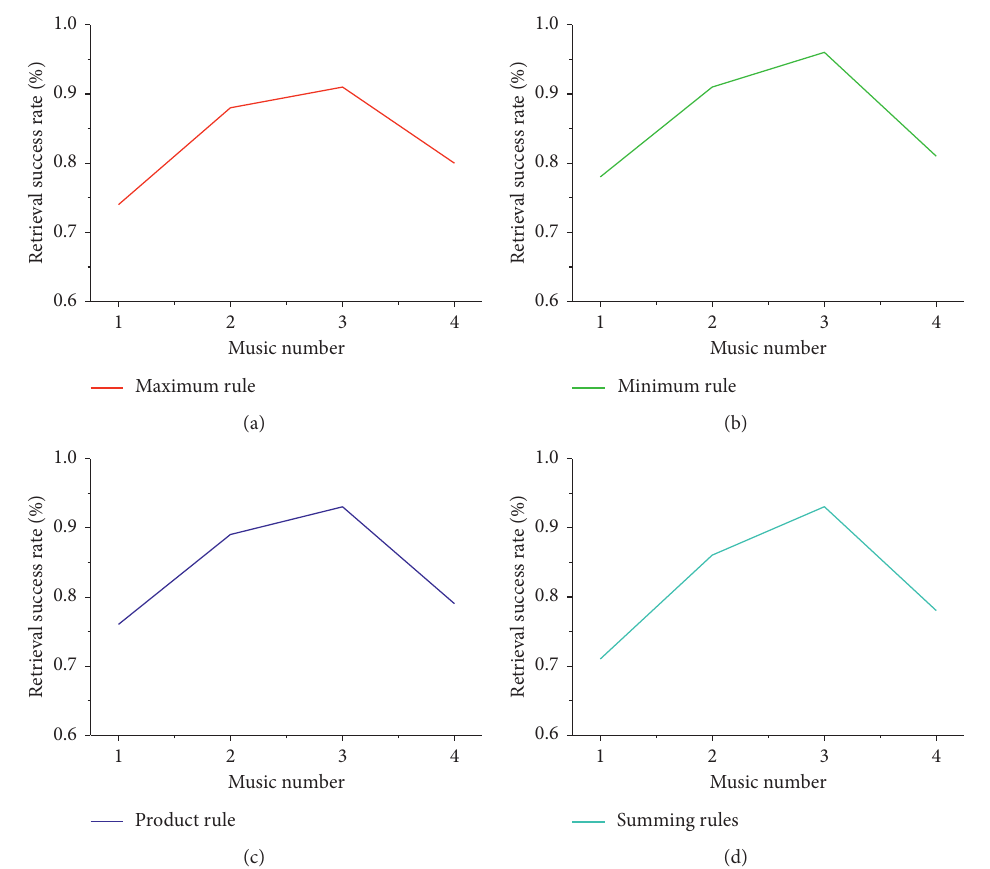
Figure 9: Matching performance at different ways of combining LS and DTW distances.